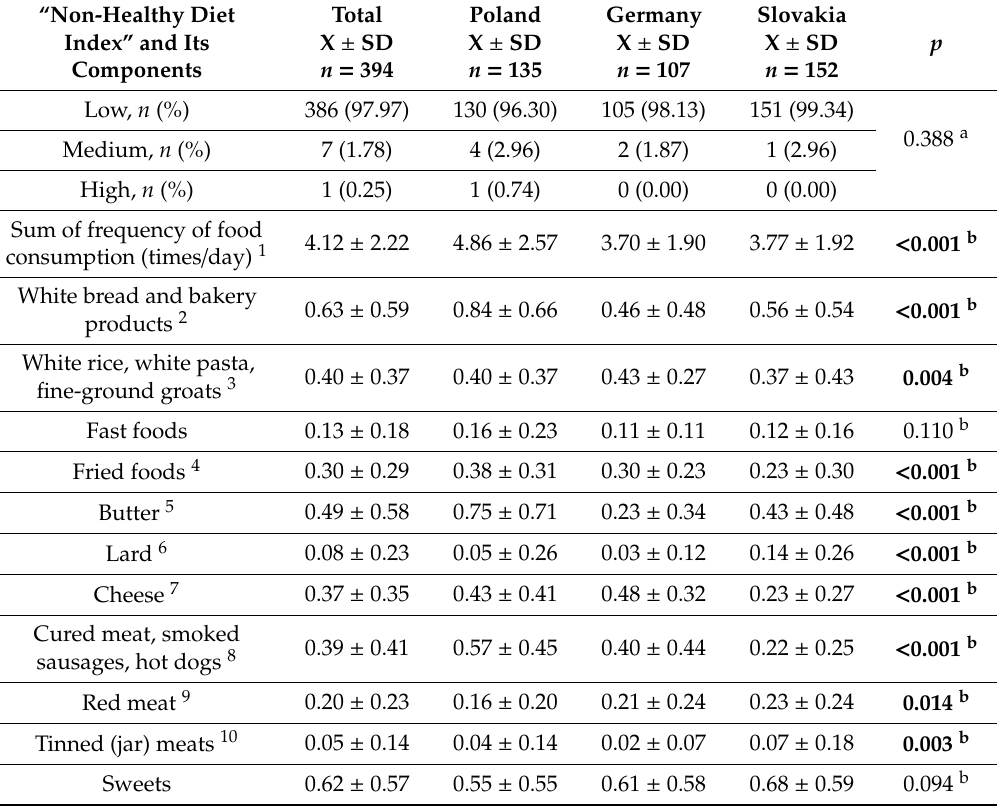
Table 3. Non-Healthy Diet Index and frequency of consumption of food groups of a potentially adverse e ff ect on health (times /